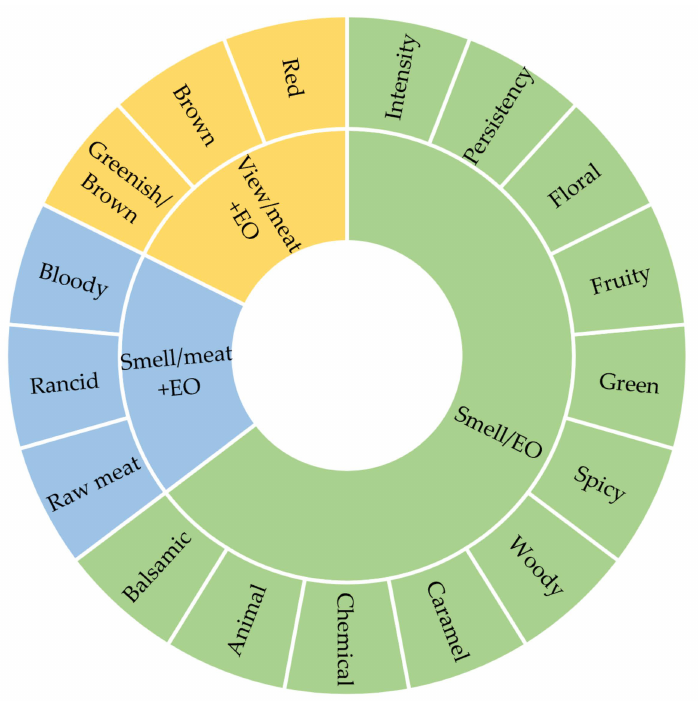
Figure 1. Sensory wheel for the essential oils (EOs) and meat + EOs evaluation (view and